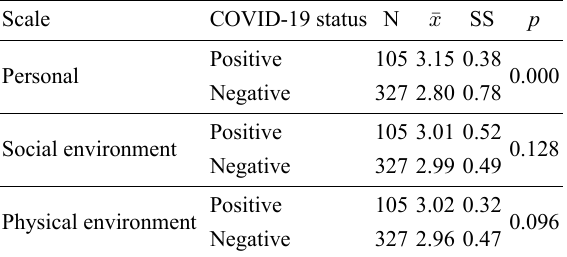
Table 4. T -test analysis for subdimensions of barriers to physical activity, by COVID-19